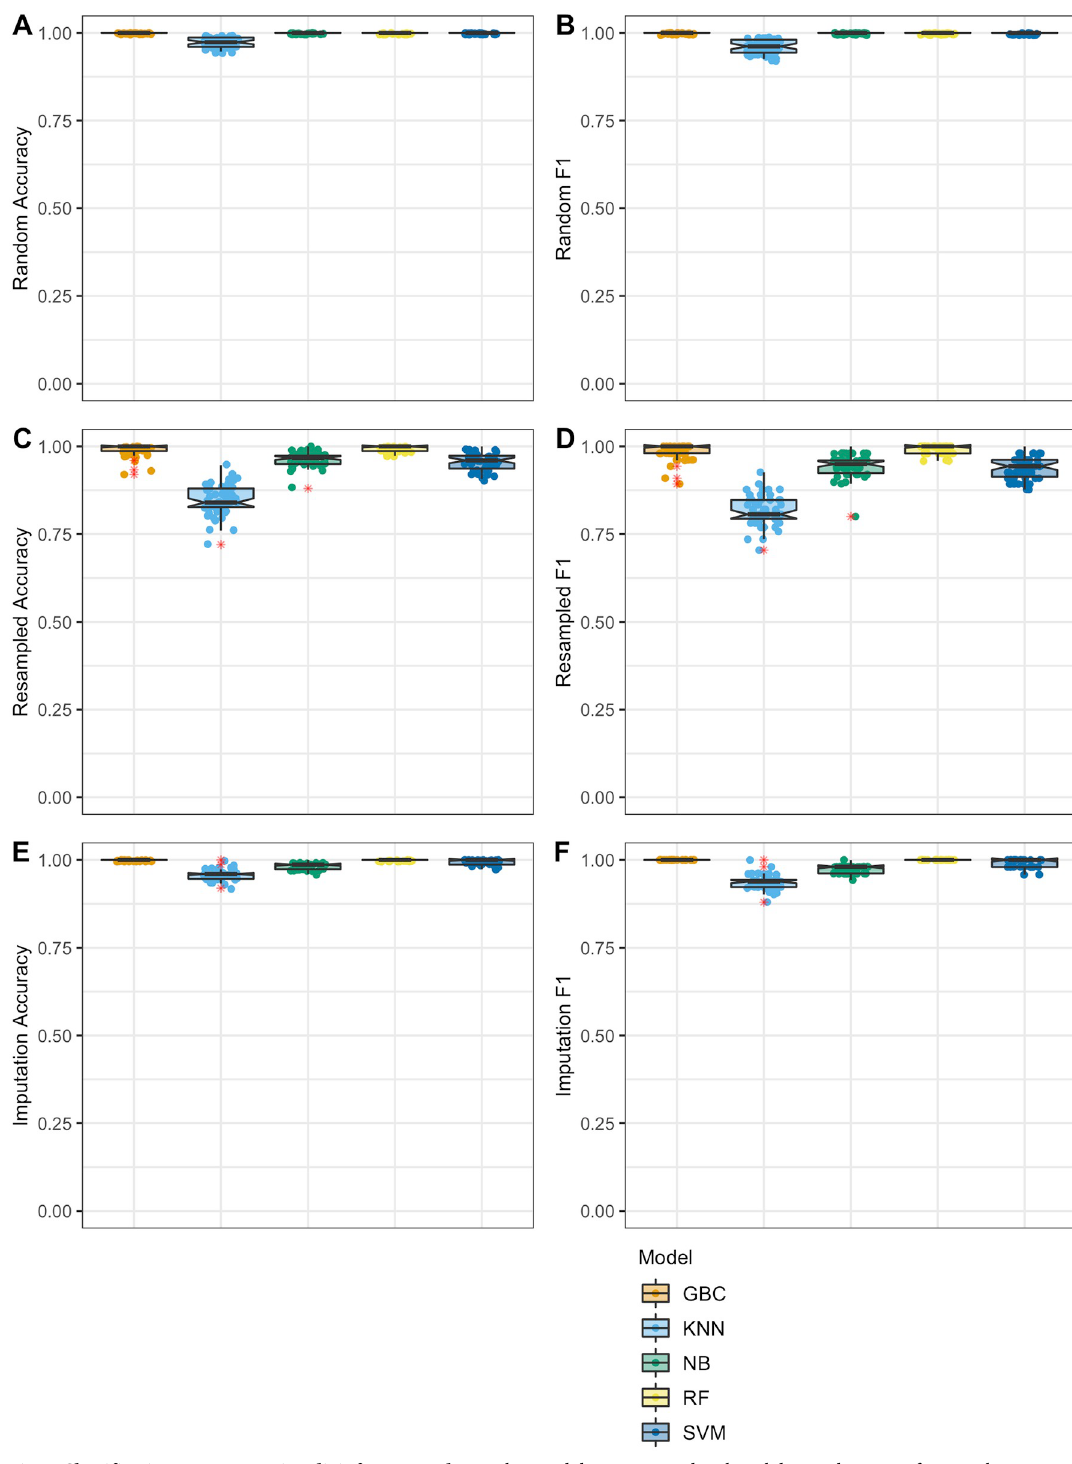
Fig 3. Classifications accuracy using digit frequency data. Fabricated data was mixed with real data and given to four machine learning models for classification. Data shown represents 50 trials for 50 different fabricated dataset mixes. Features in this dataset are the digit frequencies for each sample. The red asterisk represents outliers in the boxplot; these same outliers are shown as normally colored points in jittered-point overlay. A . Results for data fabricated with the random method, mean classification accuracy: RF 100% (+/- 0%), SVM 100% (+/- 0%), GBC 100% (+/- 0%), NB 100% (+/- 0%), KNN 97% (+/- 1.3%). B . Results for data fabricated with